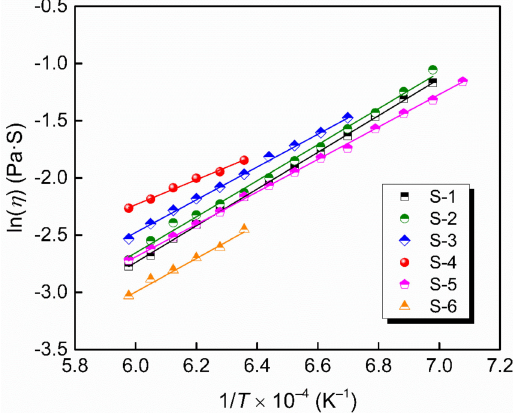
Figure 7. The natural logarithm of η as a function of 1/ T .